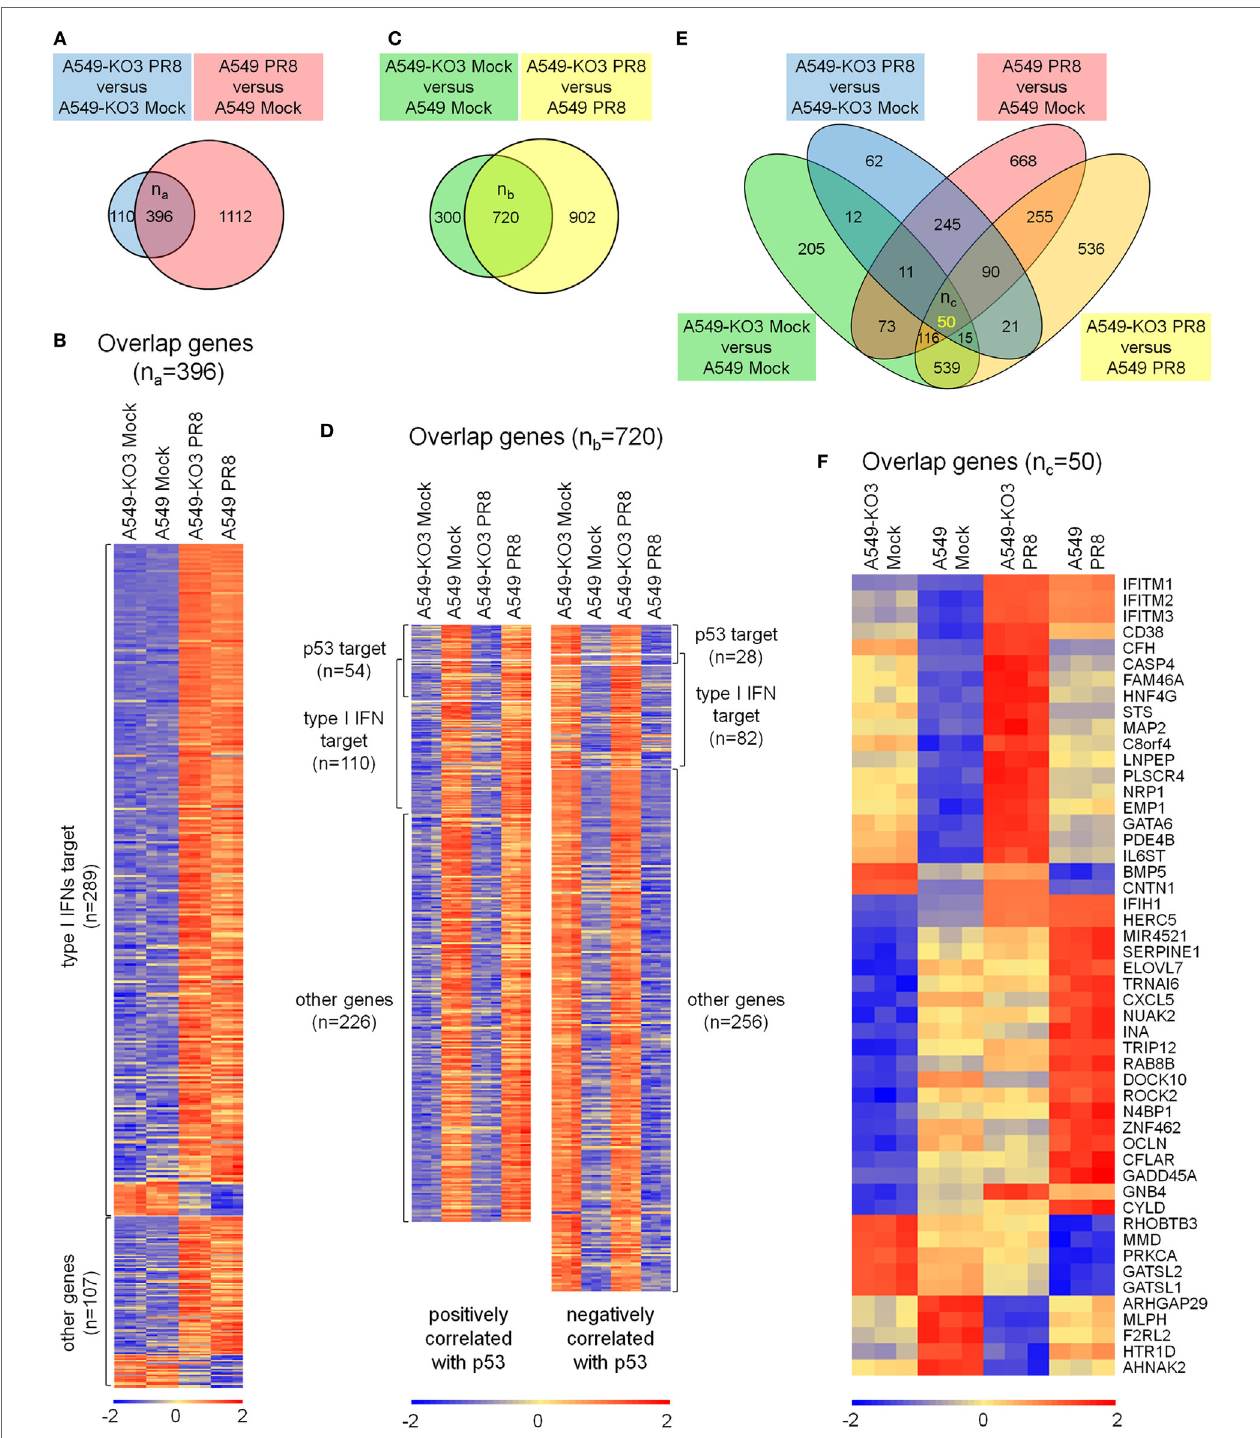
FigUre 4 | Transcriptome analysis of mock- and IAV-infected A549 and A549-KO3 cells. (a) Venn diagram of significantly differentially expressed genes in A549-KO3 PR8 versus A549-KO3 Mock (blue circle) and A549 PR8 versus A549 Mock (red circle). (B) Heatmap showing the 396 overlapping genes significantly differentially expressed in both A549-KO3 PR8 versus A549-KO3 Mock, and A549 PR8 versus A549 Mock. (c) Venn diagram of significantly differentially expressed genes in A549-KO3 Mock versus A549 Mock (green circle) and A549-KO3 PR8 versus A549 PR8 (yellow circle). (D) Heatmap showing the 720 overlapping genes significantly differentially expressed in both A549-KO3 Mock versus A549 Mock, and A549-KO3 PR8 versus A549 PR8. (e) Venn diagram of significantly differentially expressed genes in A549-KO3 PR8 versus A549-KO3 Mock (blue), A549 PR8 versus A549 Mock (red), A549-KO3 Mock versus A549 Mock (green), and A549-KO3 PR8 versus A549 PR8 (yellow). (F) Heatmap showing the 50 overlapping genes significantly differentially expressed in all four groups.